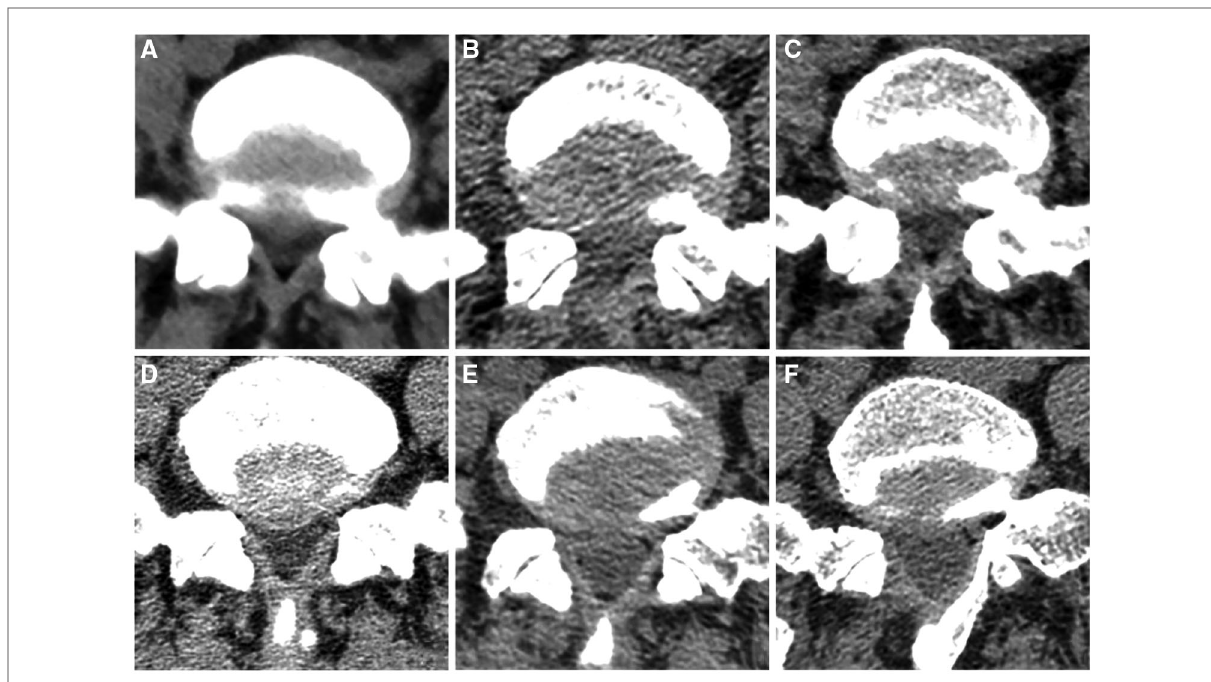
FIGURE 6 Integrity of the ligamentum fl avum on computed tomography before and after surgery in PEID group ( A – C ) and MF-PELD group ( D – F ). ( A ) Preoperative ligamentum fl avum. ( B ) Damaged ligamentum fl avum after surgery. ( C ) Scar repair in the ligamentum fl avum defect six months later. ( D ) Preoperative ligamentum fl avum. ( E ) Ligamentum fl avum after surgery has been separated from its attachment site. ( F ) Normal-appearing ligamentum fl avum with clear layers six months after surgery.